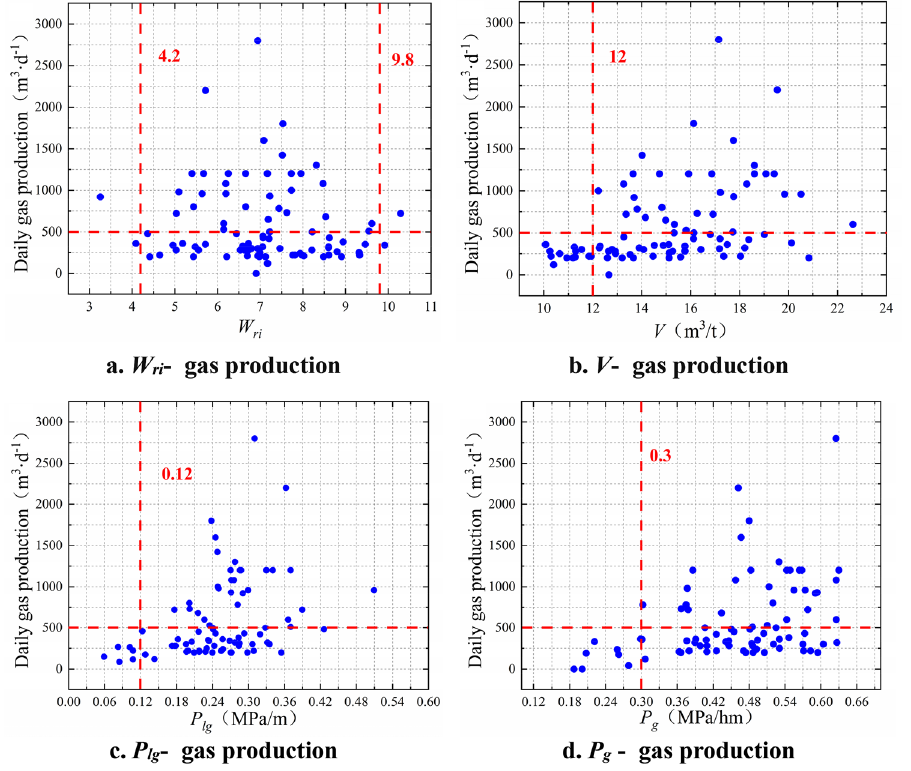
Figure 2. Determination of critical values of evaluation parameters for the gas production potential.